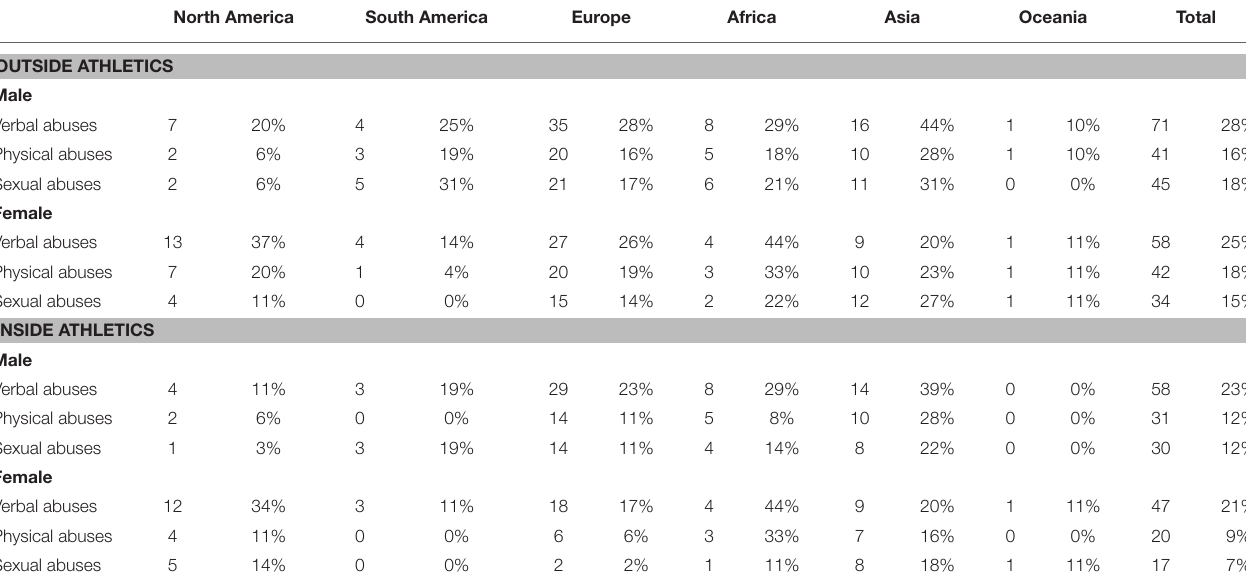
TABLE 4 | Number and proportions of lifetime verbal, physical, and sexual abuses (inside an outside the Athletics setting) victims in the study population displayed by gender and geographical area ( n =